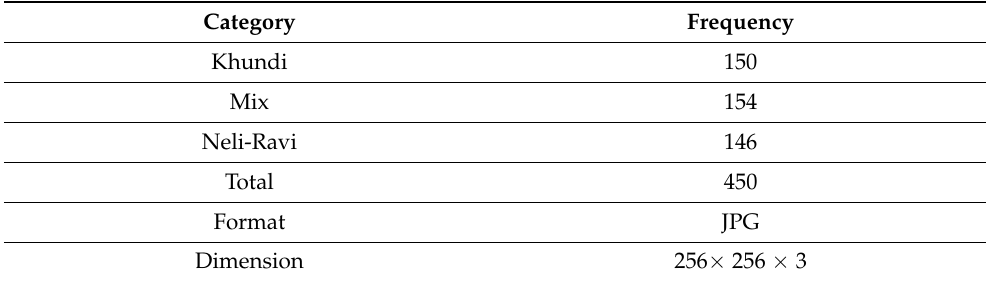
Table 2. Data-set